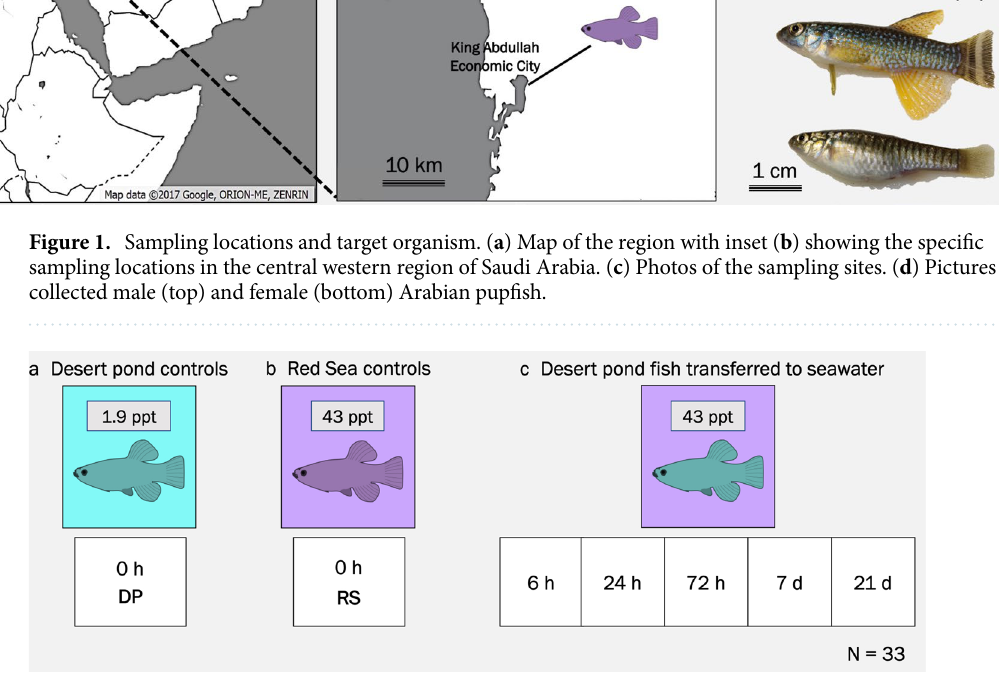
Figure 2. Experimental design. ( a ) Fish from desert pond (DP) kept in native water salinity (1.9 ppt) were sampled at time 0. ( b ) Fish from Red Sea lagoon (RS) kept in native water salinity (43 ppt) were sampled at time 0. ( c ) Fish from desert pond transferred to seawater (43 ppt) were sampled at 5 different time points. A total of 33 samples were